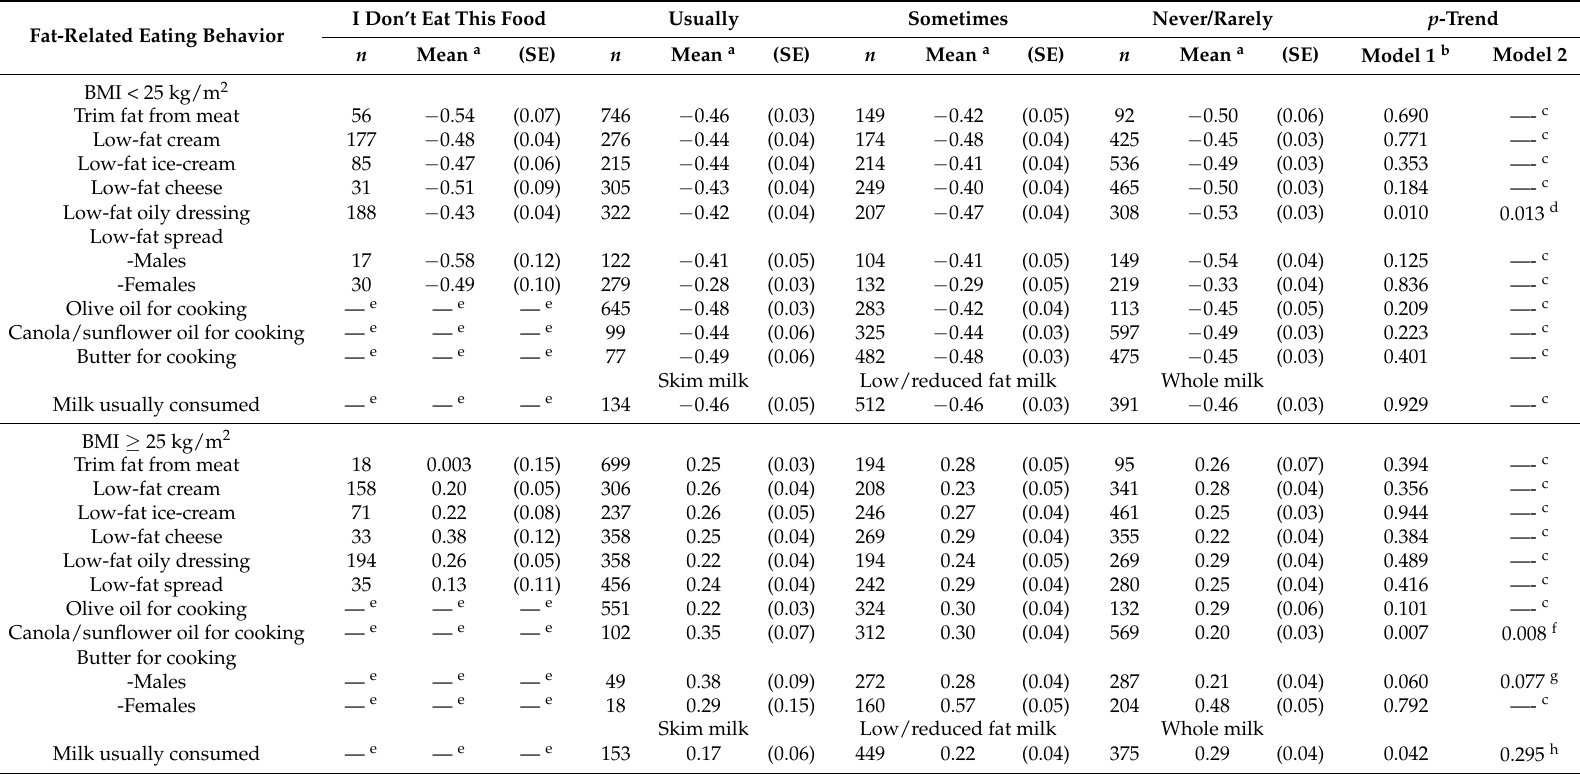
Table 3. Adjusted mean (SE) continuous metabolic syndrome score by fat-related eating behaviors, stratified by weight status, for participants from the Childhood Determinants of Adult Health